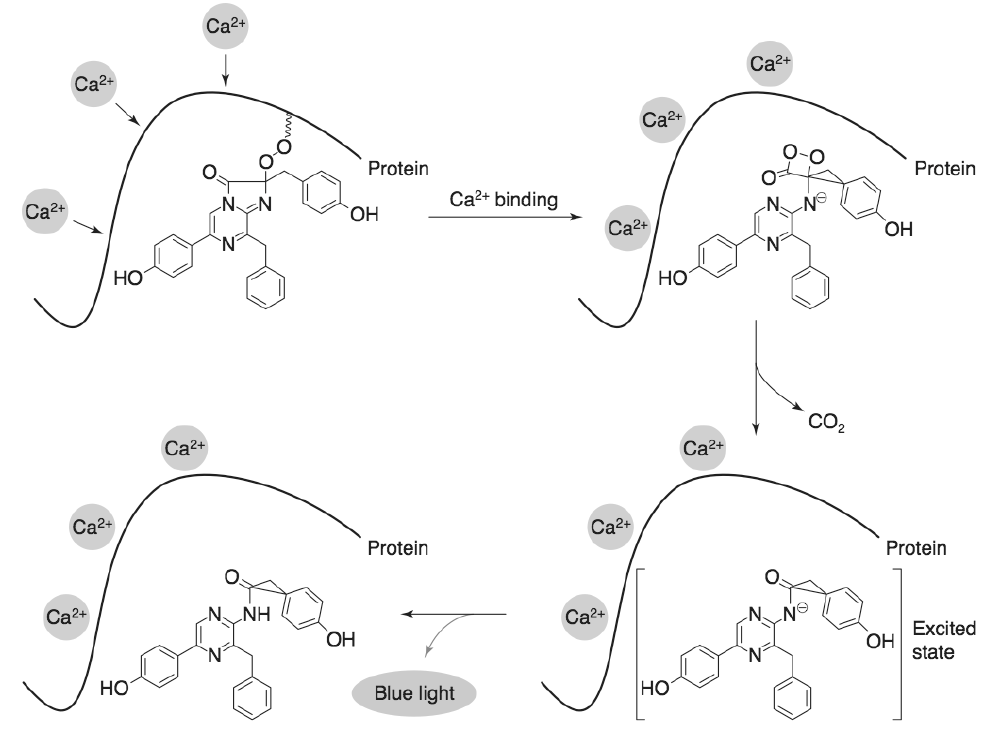
Figure 4. The bioluminescent reaction catalyzed by aequorin is dependent on the pre-bound coelenterazine luciferin. Upon calcium binding, the steric orientation of the luciferin is disturbed leading to a cyclization reaction that irreversibly forms a dioxetanone intermediate. As this intermediate decays, carbon dioxide is released and a singlet-excited anion is produced, followed by the generation of light at 465 nm. Used with permission from Jones et al .